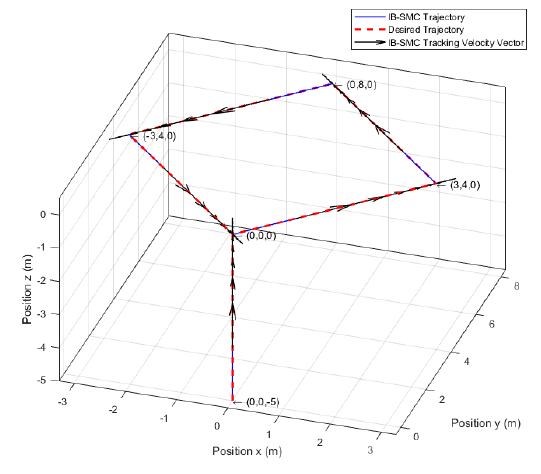
Figure 4. Three-dimensional trajectory tracking with disturbance. Figure 5a,c,e show the position response of the trajectory tracking presented in Figure 4. The position error between the desired and real trajectories with disturbance is shown in Figure 5b,d,f. At 5 s t = , the position errors in the x-, y-, and z-axes were − 0.0009372, − 0.001187, and − 0.001044, respectively.